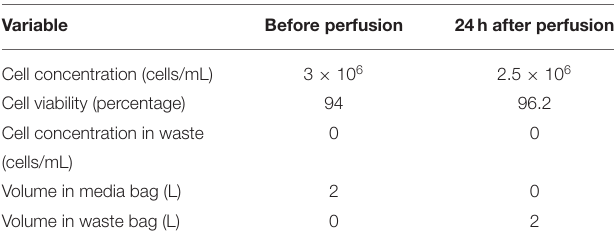
TABLE 1 | Evaluation of alternating tangential flow filtration (ATF) for continuous media perfusion and cell